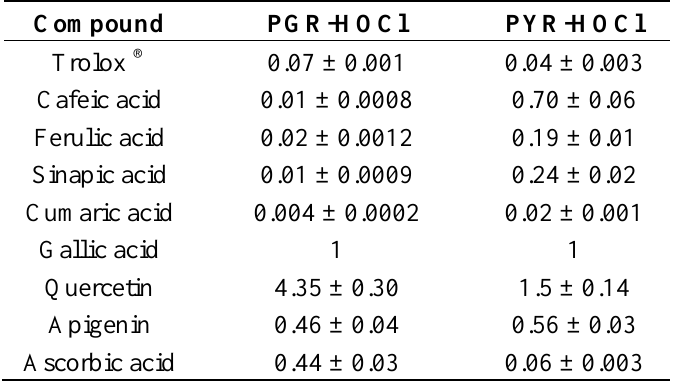
Table 1. PGR-HOCl and PYR-HOCl values (relative to gallic acid activity) of pure antioxidants. Data represent the mean of at least three independent experiments. Standard deviation (SD) represented less than 10% of the